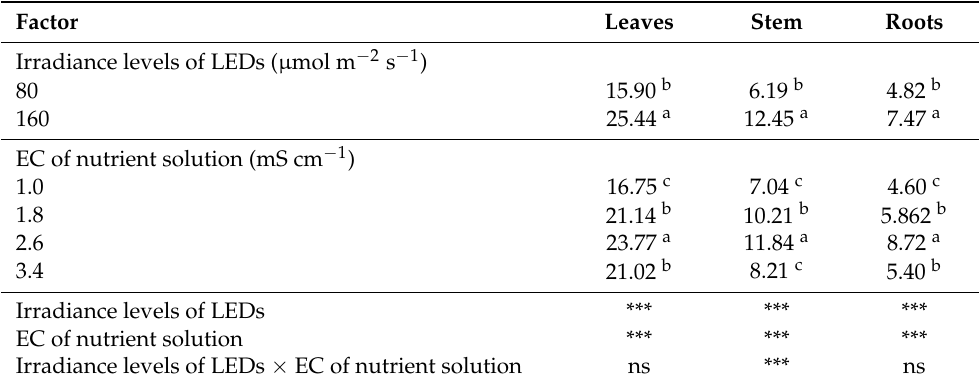
Figure 3. Number of lemon basil leaves after 30 days growing duration under different LEDs and nutrient solution ECs. Table 2. Effects of LED irradiance levels and nutrient solution EC on the fresh weight (g) of three different parts (leaves, stem, and roots) of lemon